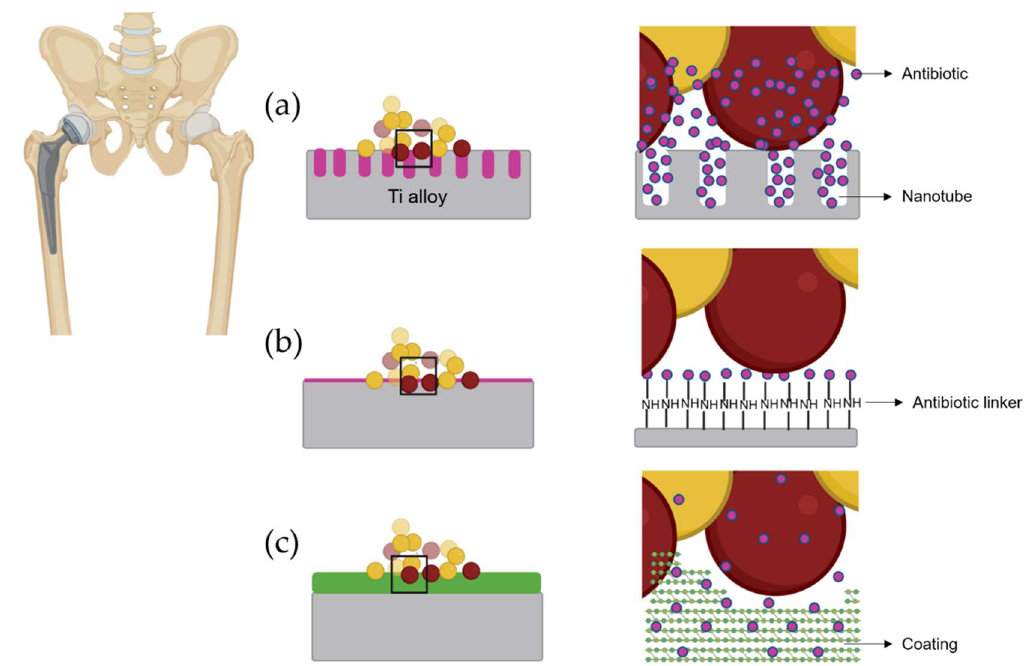
Figure 1. Different local antibiotic therapy strategies. ( a ) Antibiotic-loaded nanotubes. ( b ) Antibiotic covalently bound to titanium alloy. ( c ) Antibiotic-loaded coating. Yellow represents live bacteria. Red represents dead bacteria.